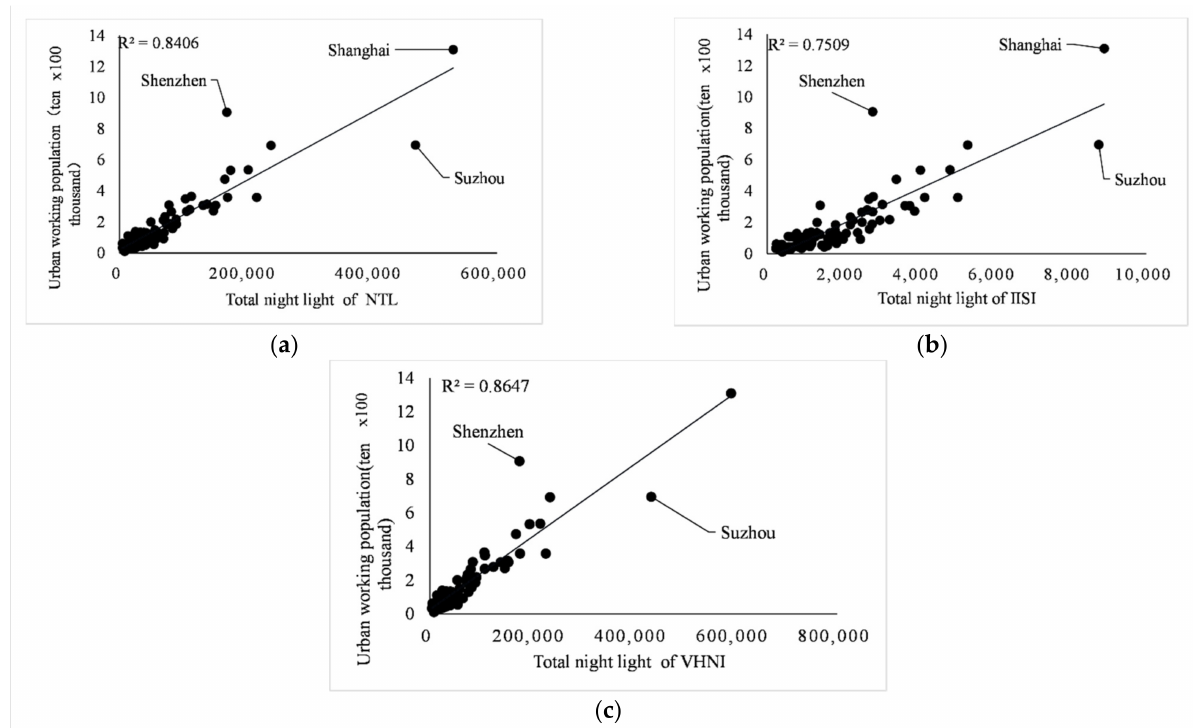
Figure 9. ( a – c ) Fitting relationships between NTL , IISI , VHNI and urban employed population